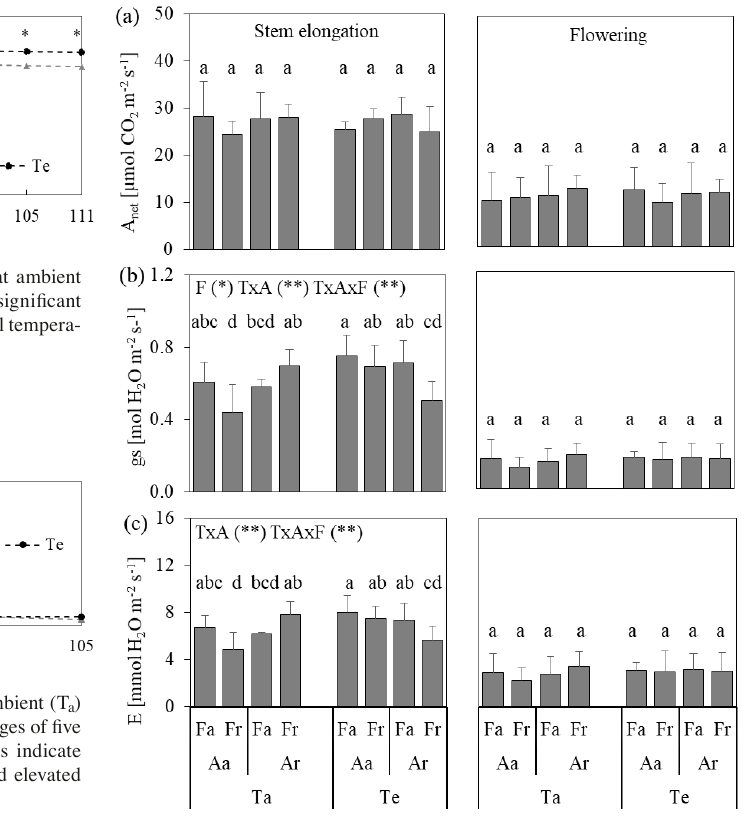
Fig. 4: Reactions of net photosynthesis (A net ) (a), stomatal conductance (g s ) (b), and transpiration (E) (c) to changes in soil temperature (T a , am- bient; T e , elevated), precipitation amount (A a , ambient; A r , reduced) and precipitation frequency (F a , ambient; F r , reduced). Measure- ments were performed at stem elongation and flowering. Means and SDs are shown, asterisks indicate significance (*P ≤ 0.05, **P ≤ 0.01) tested by three-way ANOVA applied to a mixed-effects model; n = 3. Different letters indicate significant differences between treat - ments (LSD test, P ≤